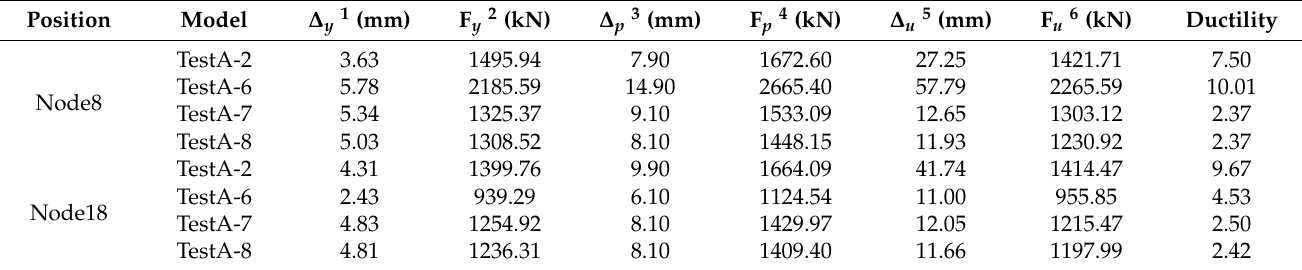
Table 3. Displacement ductility of